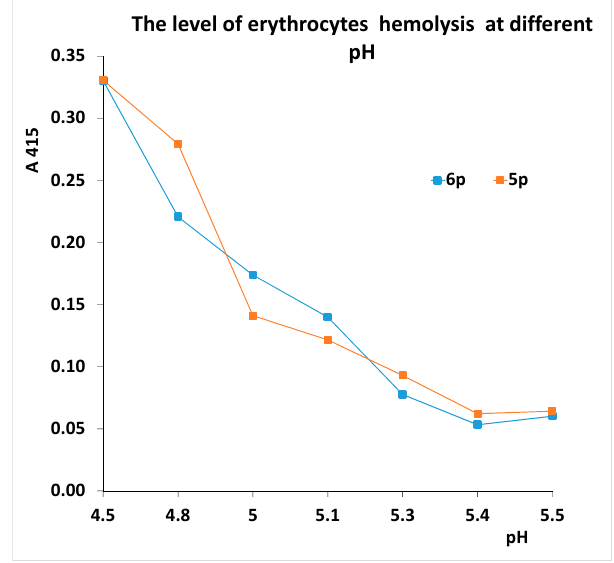
Figure 4. The pH dependence of erythrocyte hemolysis in complex with R5p and R6p viruses. A 415 — absorption at 415 nm, which corresponds to the degree of erythrocyte hemolysis. Result of a typical experiment is presented.